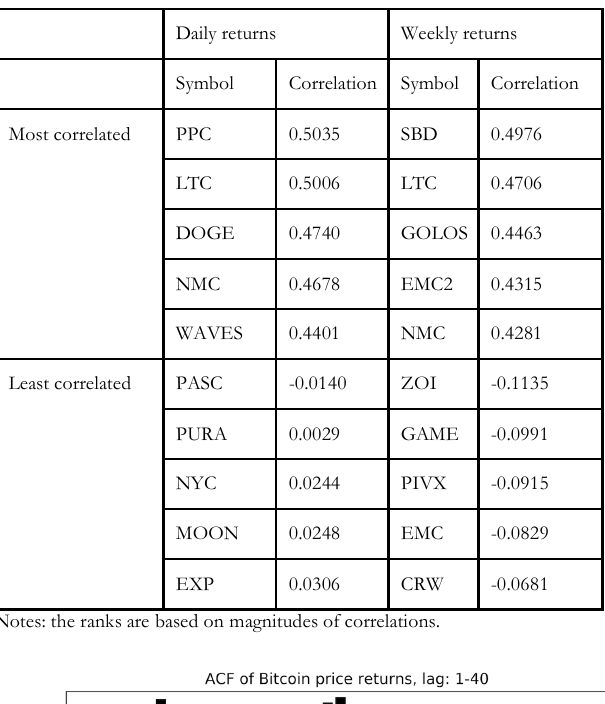
Table 8: Most and least correlated cryptocurrencies with Bitcoins (Jan 2015 - Feb 2018)